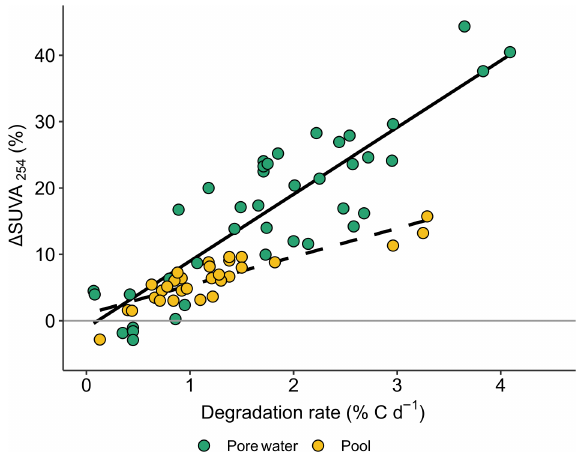
Figure 5. Relations between changes in SUVA 254 ( (cid:49) SUVA 254 ) during incubation experiments and linear regression in peat pore- water (solid line) and pools (dashed